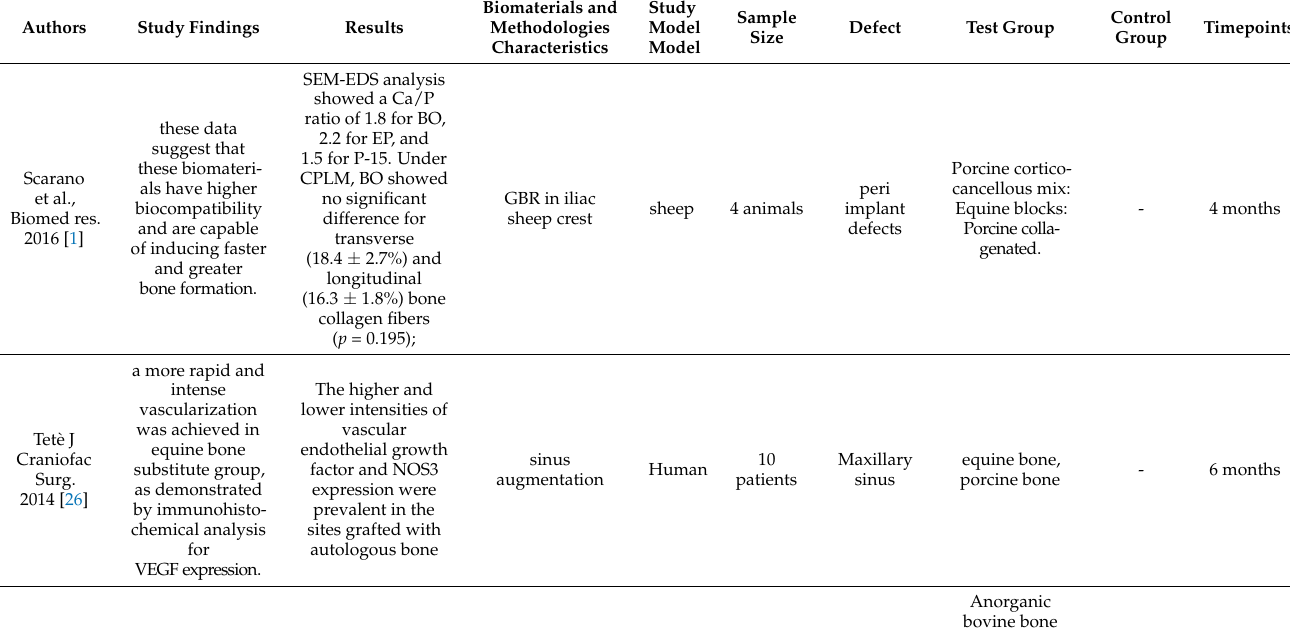
Table 3. Summary table of the equine bone (EQ) findings of the papers